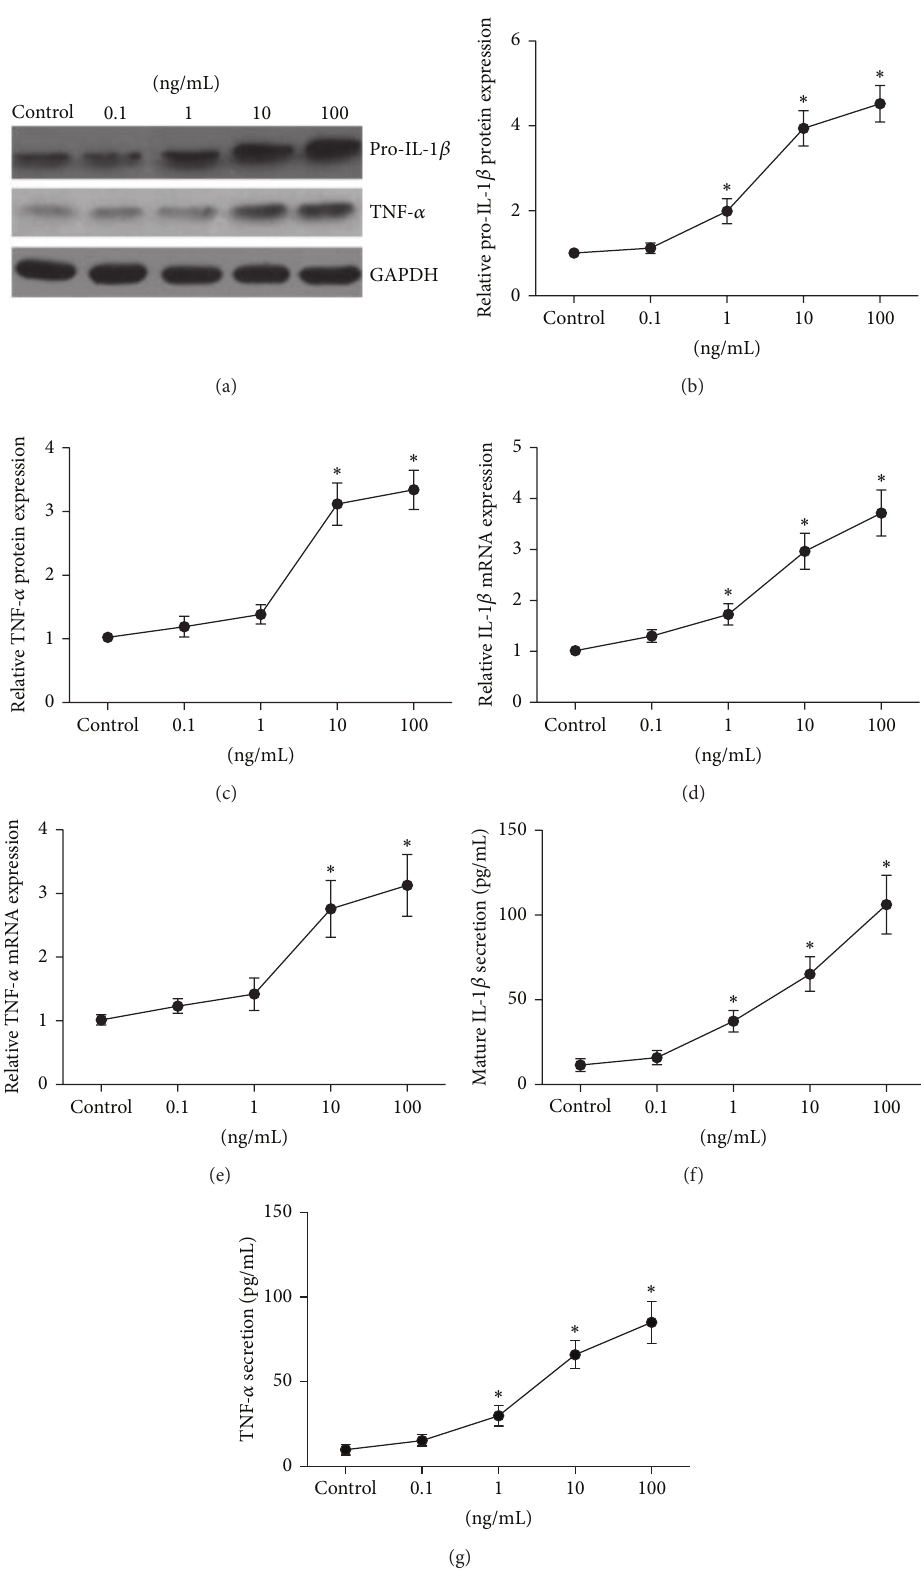
Figure 2: LPS induced IL-1 𝛽 and TNF- 𝛼 expression in SFs in a dose-dependent manner. SFs were treated with LPS (0.1, 1, 10, 100 ng/mL) for 12h, cellular lysates were subjected to Western blotting to detect theprotein expression of pro-IL-1 𝛽 and TNF- 𝛼 (a), and therelative expression of pro-IL-1 𝛽 (b) and TNF- 𝛼 (c) was calculated. The expression of IL-1 𝛽 (d) and TNF- 𝛼 (e) mRNA was determined by real time quantitative PCR. Mature IL-1 𝛽 (f) and TNF- 𝛼 (g) proteins secreted into the cell culture media were measured by ELISA. Data shows all the values from independent samples of 𝑛 = 3 , ∗ 𝑃 < 0.05 versus nonstimulated